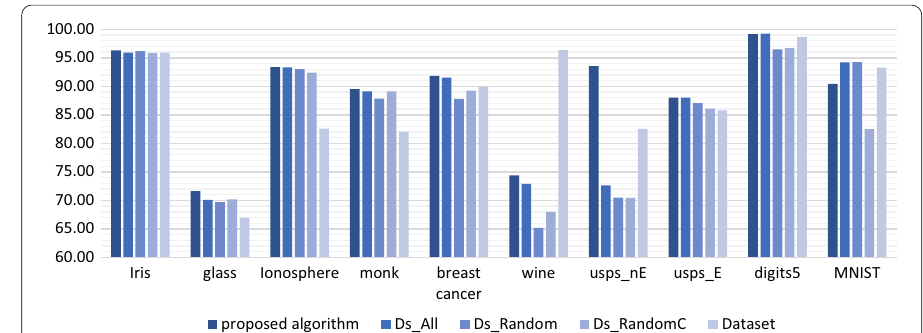
Fig. 7 Average classification accuracy of proposed method and other dissimilarity spaces on evaluation datasets